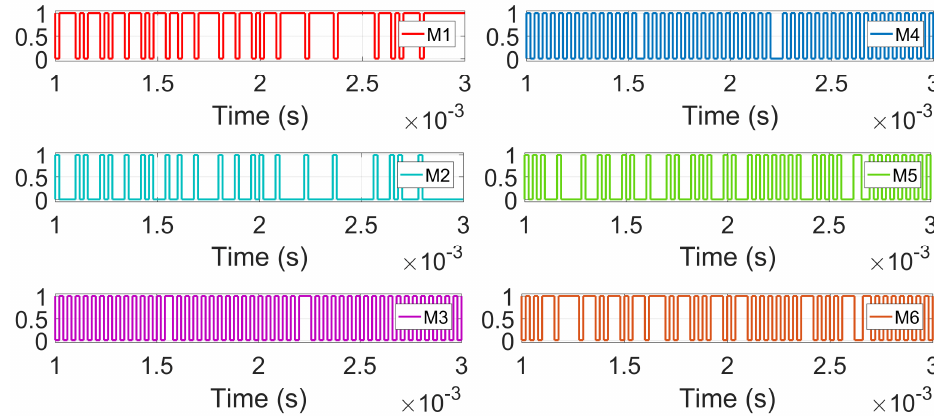
Figure 9. Switching pulses to drive inverter switches.